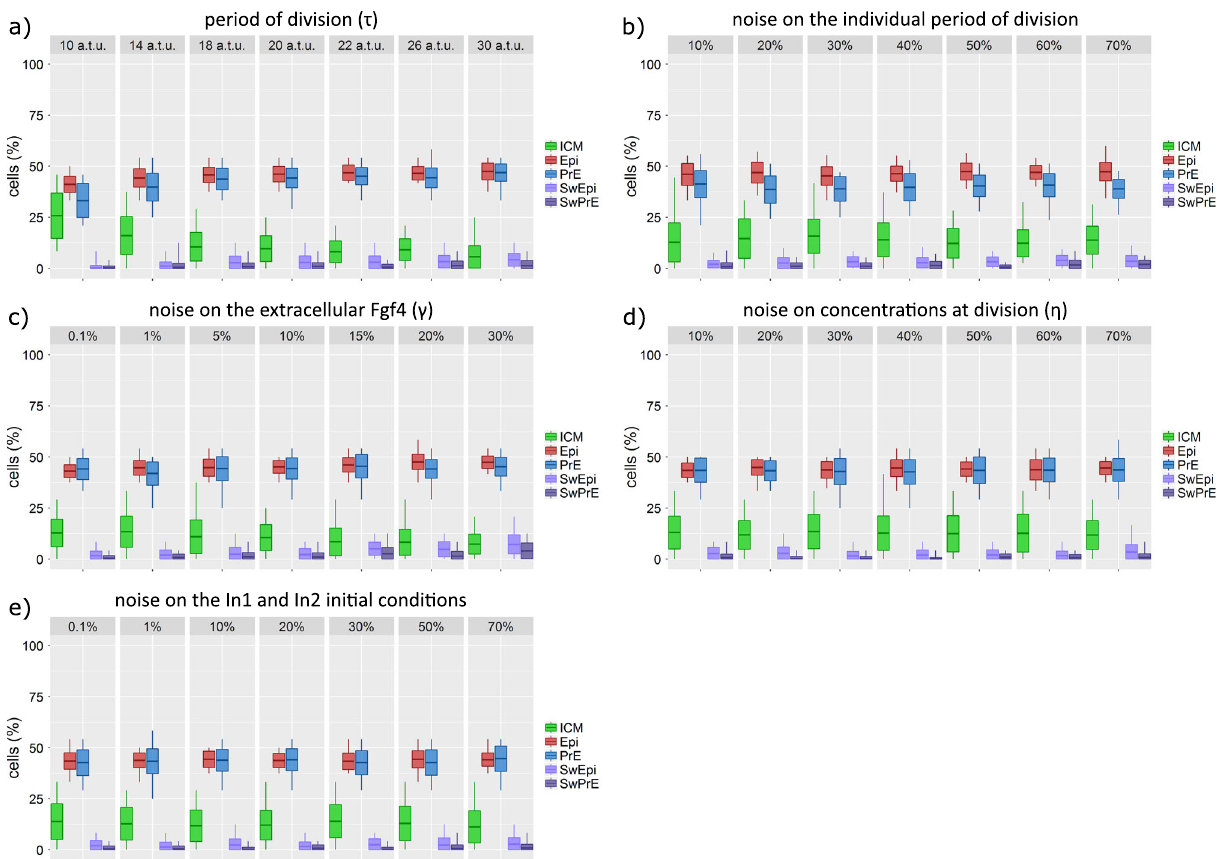
Fig. 6 Analysis of embryo development sensitivity on: a the mean division period ( τ ), b the noise on the timing of individual cell divisions, c the noise on the extracellular Fgf4 ( γ ), d the noise on repartition of gene regulatory network ( GRN ) factors in daughter cells at division ( η ), e the noise on the initial conditions of Nanog, Gata6, Fgf receptors and Erk in both In1 and In2 cells. Each graph shows the mean cell count, standard deviation ( box ) and minimal and maximal cell count ( vertical line ) at E4.0 for inner cell mass ( ICM ), epiblast ( Epi ), primitive endoderm ( PrE ) cells and as well as for the number of switches from PrE to Epi ( SwEpi ) and from Epi to PrE ( SwPrE ). a and b show that the model is quite robust on the moderate changes in the cell division period and on the noise on the timing of individual cell divisions. A more detailed description of the analysis presented in this fi gure is given in section 5 of Supplementary